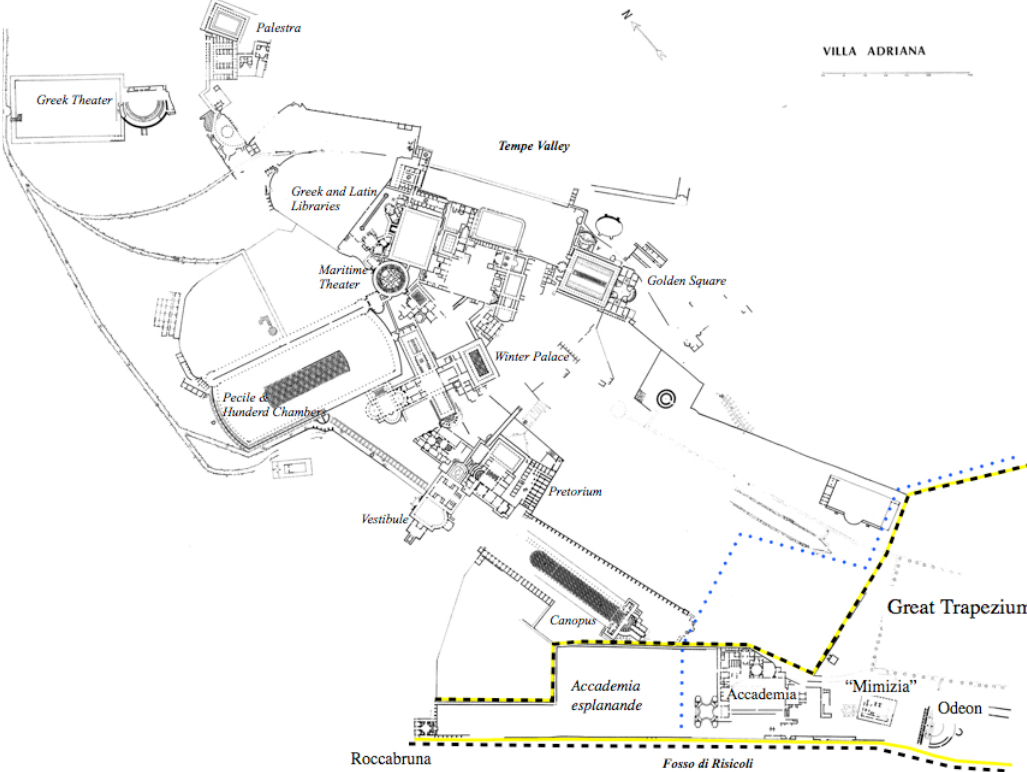
Fig. 1. General plan of Hadrian’s Villa: on lower right is outlined the Accademia Esplanade area. Blue dots mark the border between public and private property (from Salza Prina Ricotti,